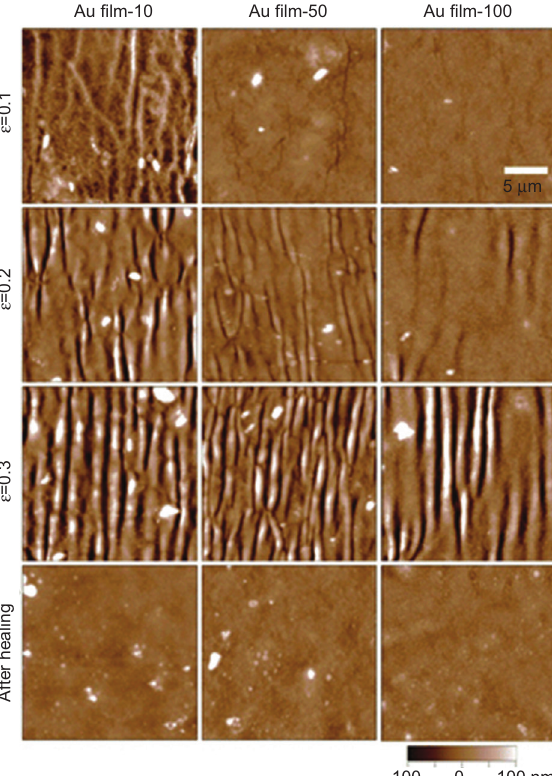
Figure 5 AFM images of AuNP multilayer hydrogels with different AuNP contents and after exposure of water (reprinted with permis- sion from [32]). Copyright 2010,